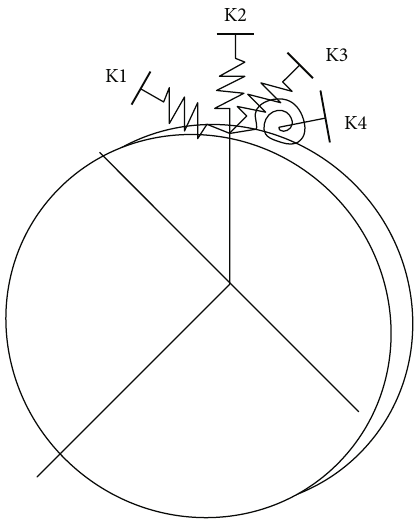
Figure 1: Diagrams of displacement and restraint conditions for mine protection complex steel structures.